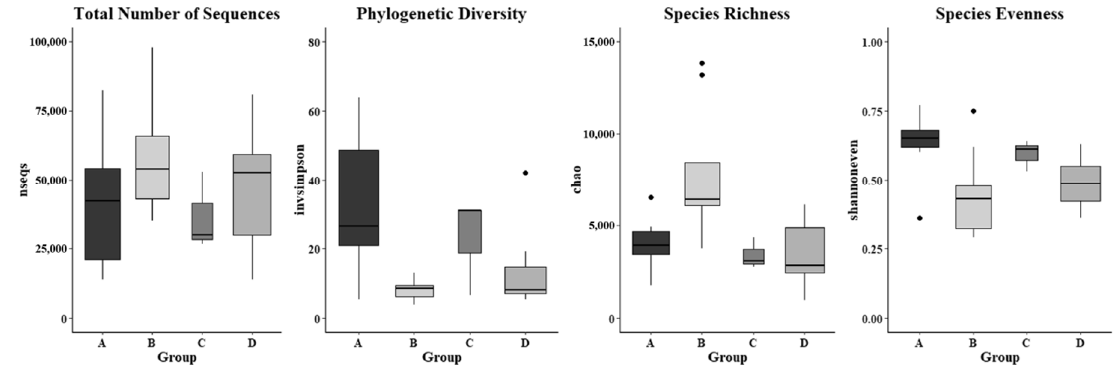
Figure 7. Microbial diversity of forearm skin microbial ecosystem. Alpha diversity indices of nseqs (total number of sequences), invsimpson (phylogenic diversity), chao (species richness), and shannoneven (species evenness) in the investigated individuals from the Dairy farm in Clarksville ( A ), the integrated farm in Upper Marlboro ( B ) and Washington DC ( C ), and University of Maryland—College Park campus ( D ). Letters a and b indicate significant differences among groups based on ANOVA. The widths of the boxes represent the variances in the observations.